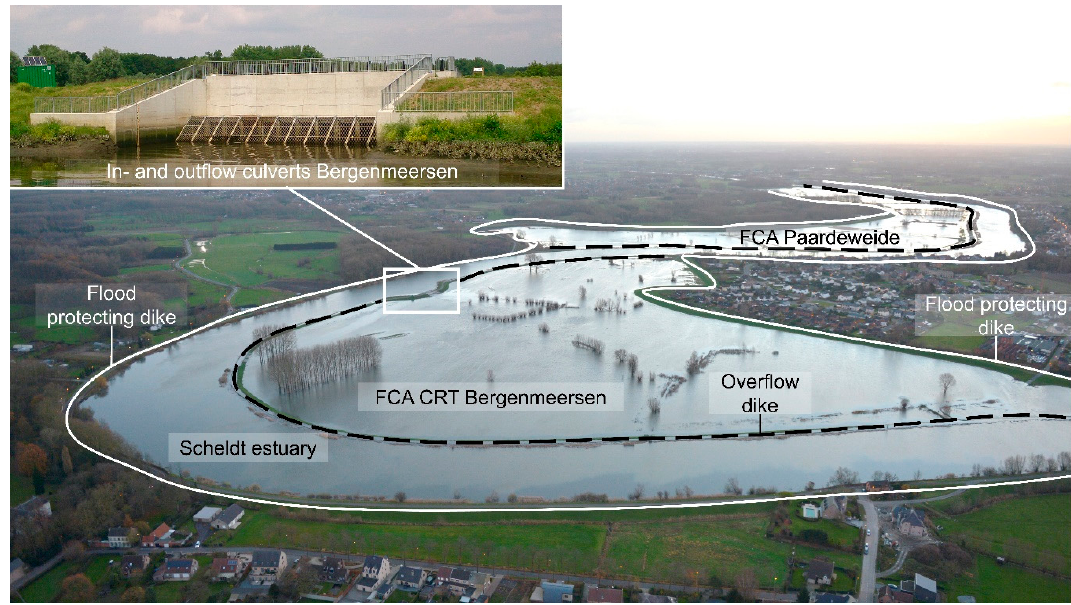
Figure 3. Helicopter photo of FCA Bergenmeersen on the morning of 6 December 2013, one hour after high water level of the ‘Sinterklaas’ storm surge (6/12/2019 09:25 local time). The thin white line indicates the location of the flood protecting dike and the thicker black dashed line indicates the location of the overflow dike. The panel in the top left corner gives a closer view on the in- and outflow culvert construction seen from within the FCA when the water level is low. The trash screens are visible.